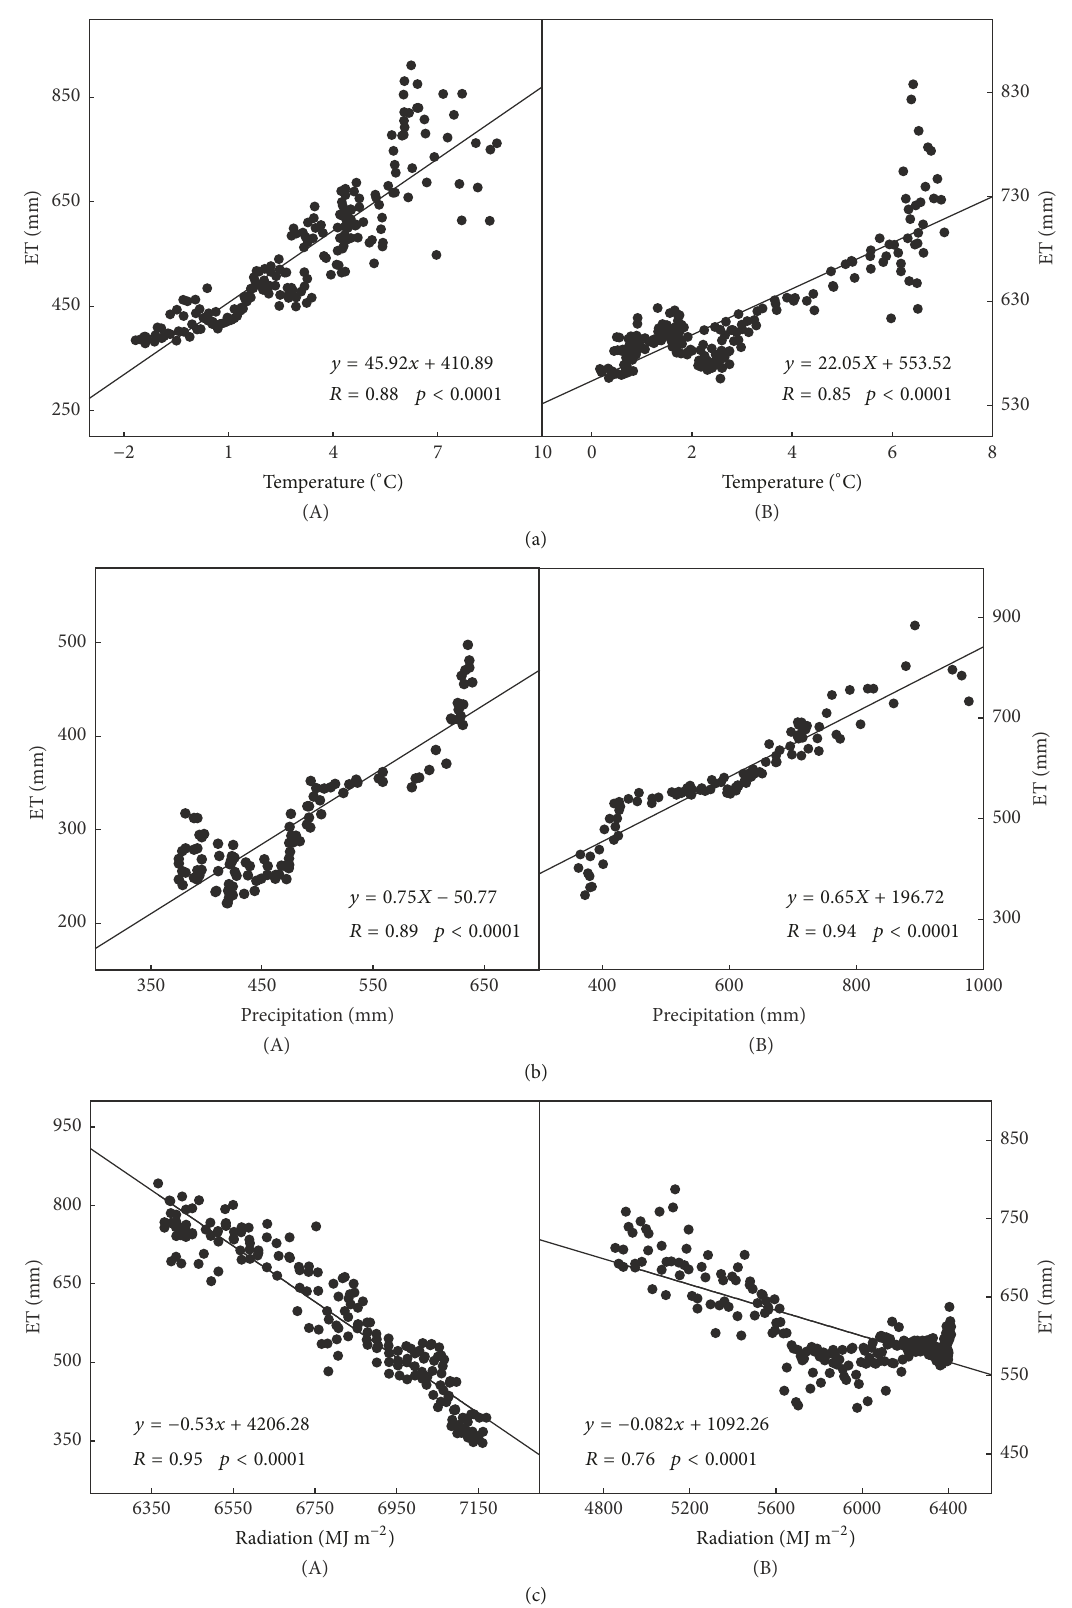
Figure 8: Relationship of three environmental factors with ET. Graphs (a)(A) and (a)(B) represent the relationship between ET with temperature in temperature gradients a and b; graphs (b)(A) and (b)(B) with precipitation in precipitation gradients a and b; and graphs (c)(A) and (c)(B) with radiation in radiation gradients a and b,